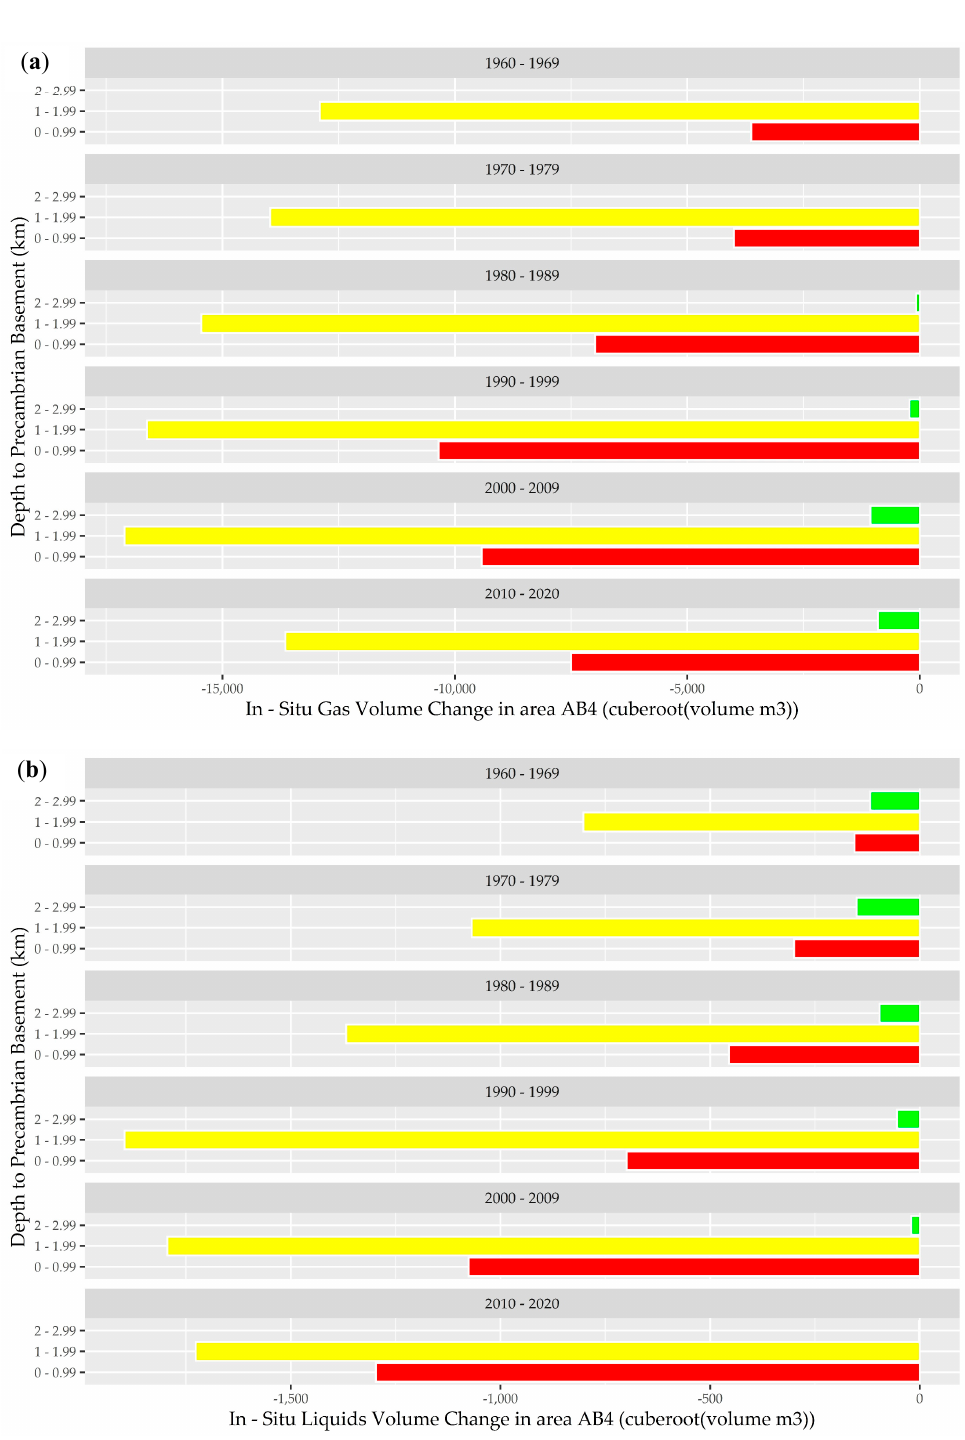
Figure 6. Calculated net in situ ( a ) gas and ( b ) liquid balance for AB4 over the period January 1960–December 2020. Red bars: <1 km depth from Precambrian basement; Yellow bars: 1–2 km depth from Precambrian basement; Green bars: 2–3 km depth from Precambrian basement. Source data extracted from geoLOGIC Systems databases ©